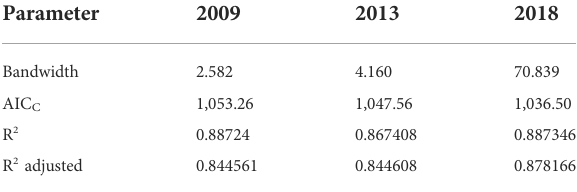
TABLE 8 Parameter estimation and test results of